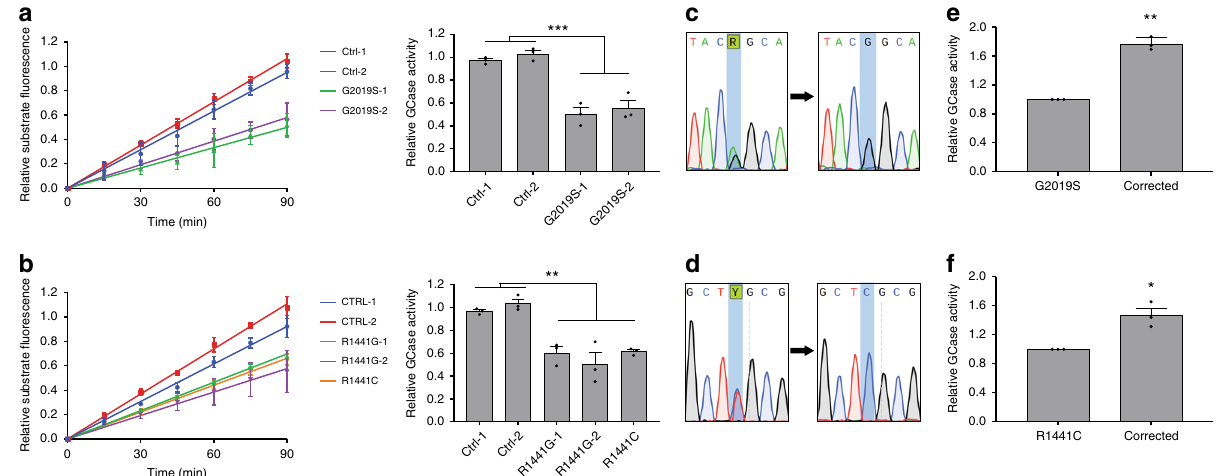
Fig. 1 GCase activity is reduced in DA neurons with LRRK2 mutations. Live-cell measurement of fl uorescent unquenching resulting from hydrolysis of the arti fi cial GCase substrate PFB-FDGlu by lysosomal GCase in LRRK2 G2019S ( a left panel) and R1441G/C ( b left panel) DA neurons relative to healthy controls over 90 min. GCase activity was determined by analyzing the relative slope of these measurements ( a , b right panel). Sanger sequencing results from LRRK2 G2019S c and R1441C d lines and subsequent isogenic controls generated using CRISPR/Cas9. Relative lysosomal GCase activity in DA neurons with LRRK2 G2019S e and R1441C f mutations compared to isogenic corrected controls. The data are presented as the mean ± SEM, n = 3; * p < 0.05, ** p < 0.01, *** p < 0.001, using one-way ANOVA followed by Tukey ’ s multiple comparison post hoc test a , b , or paired two-tailed t -test e , f . Source data are provided as a Source Data fi